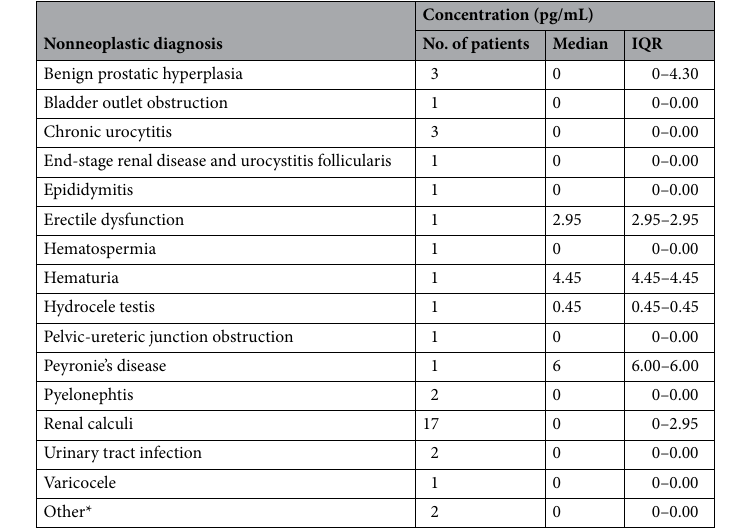
Table 2. Control group according to nonneoplastic diagnosis. Abbreviations IQR: interquartile range. *Consists of 2 patients with dilated